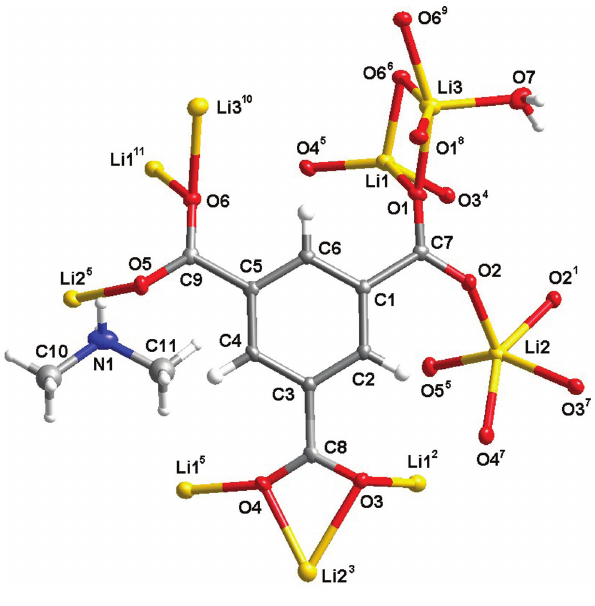
Table 1 contains crystallographic data and Table 2 contains the list of the atoms including atomic coordinates and dis- placement parameters.